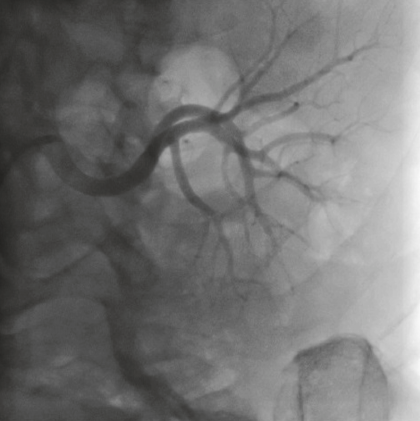
Figure 3: Final renal angiography showing completely lysed throm- boembolic materials in the left renal artery